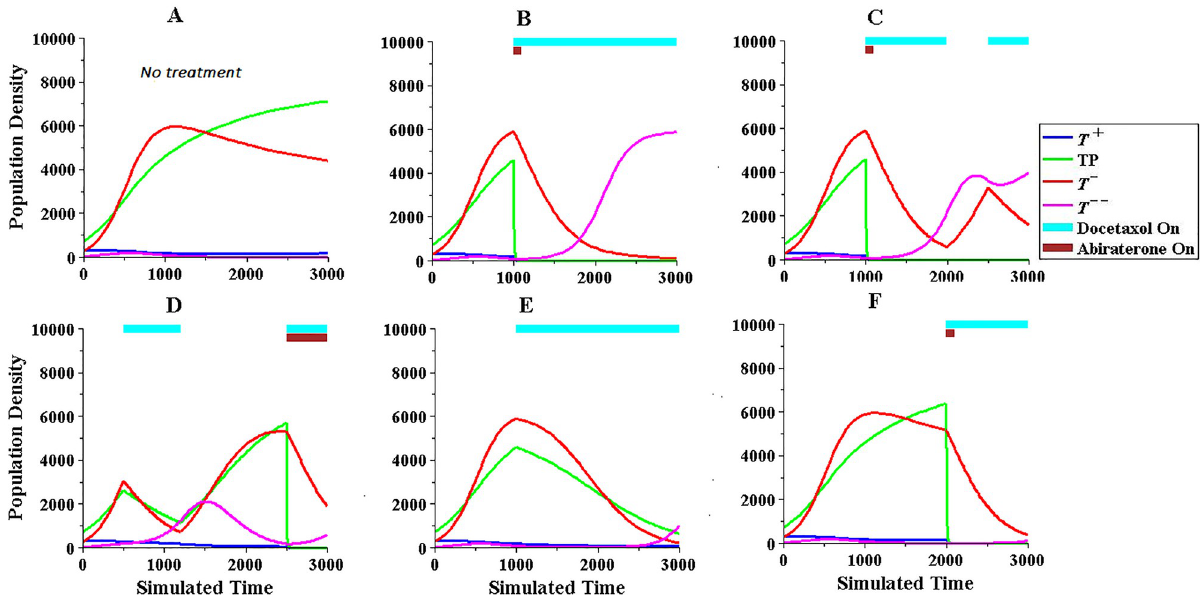
Fig 2. Comparison of some treatment methods on cell population dynamics in non-responder group with best result shown in 2F.